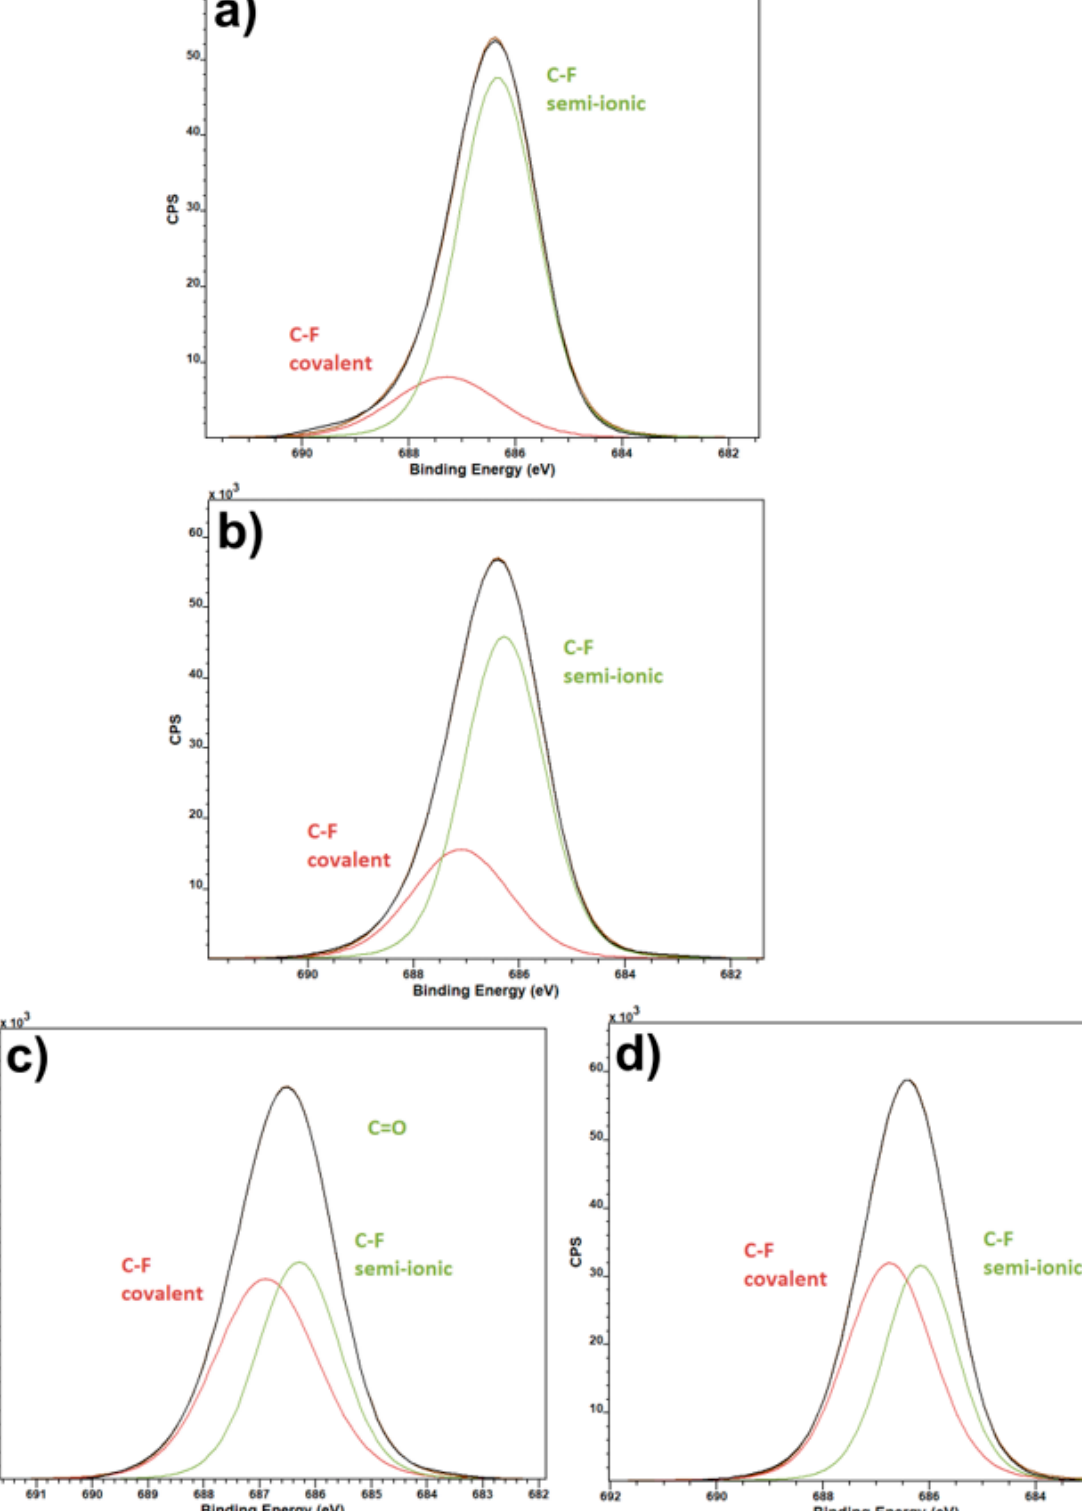
Figure 3. XPS F1s spectra of pure PVDF fibers ( a ) and PVDF fibers with Ca(NO 3 ) 2 ( b ), Mg(NO 3 ) 2 ( c ) and Zn(NO 3 ) 2 ( d ). Unique elements spectra (Figure 4) serve as a check for the presence of the specified salts in the intended samples. Since it is virtually impossible to tell whether or not the